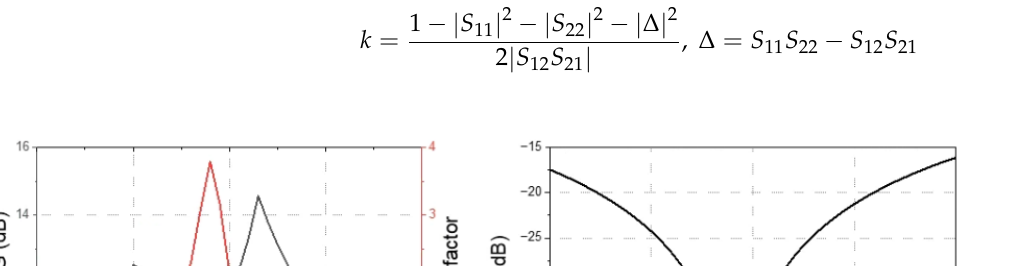
Figure 5. MSG/MAG, stability factor, and reverse isolation according to C neu at 70 GHz.